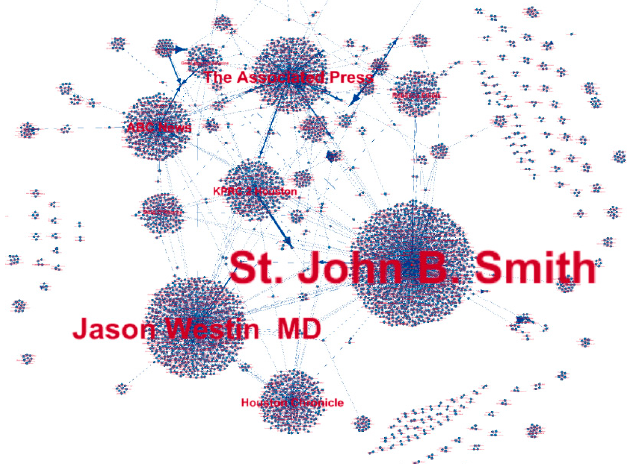
Figure 10. Social network relations of the Toyota Center Shelter Event. The blue arrows represent the paths of information transferred (retweeted) from its original resource. Red texts are the source names (twitter account), and text font size is indicative of how wide the information is being broadcasted.